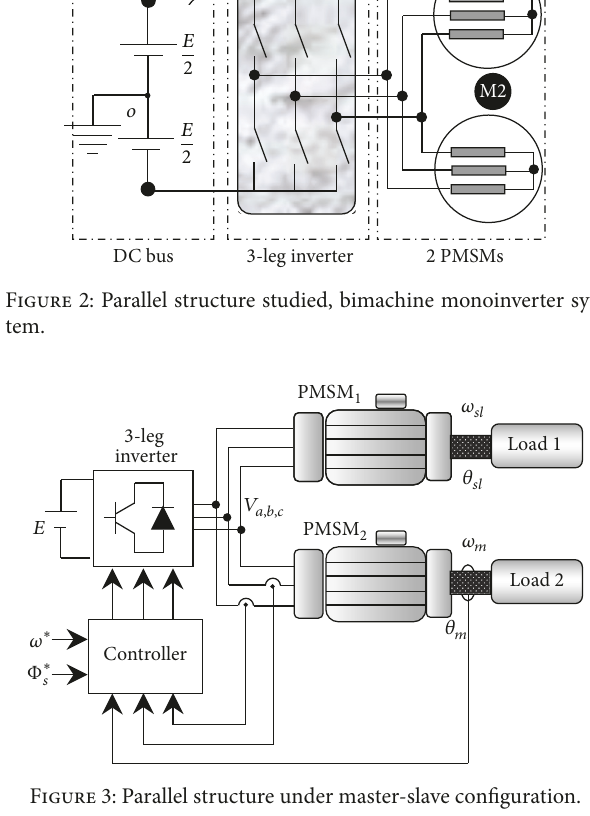
Figure 3: Parallel structure under master-slave configuration.